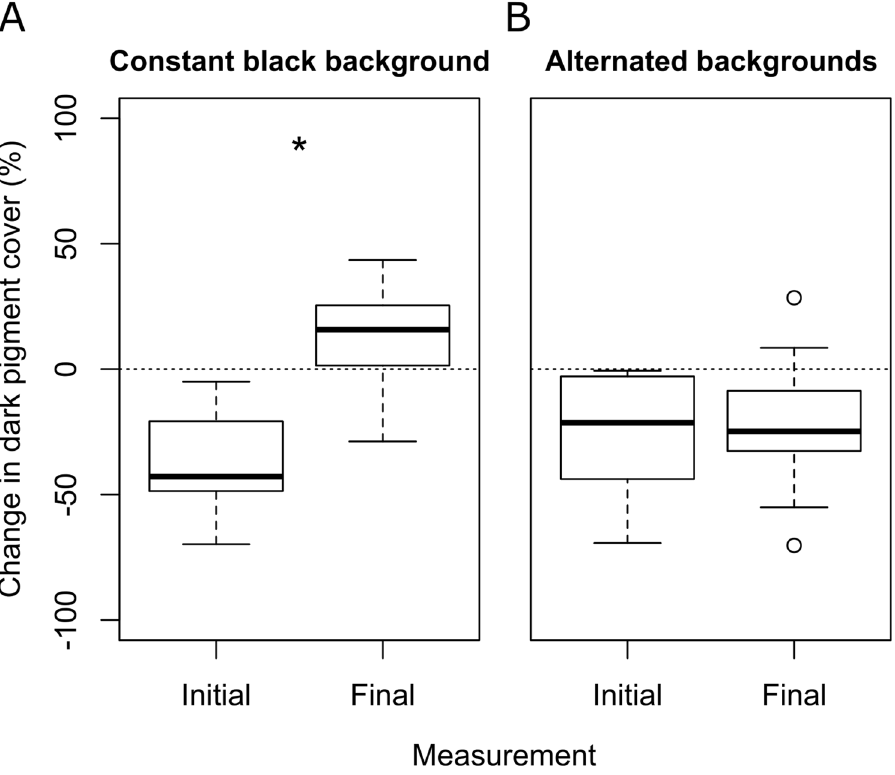
Figure 7. Effect of long term background adaptation on Crangon crangon colour changes. Box-and-whisker plots show the change in dark pigment cover within one hour of shrimp transferred from a black to a white background. Shrimp were first tested at day 0 (initial), than exposed to either ( A ) a constant black background (N = 11) or ( B ) daily alternating black and white backgrounds (N = 15), and tested a second time at day 21 (Final). * P <